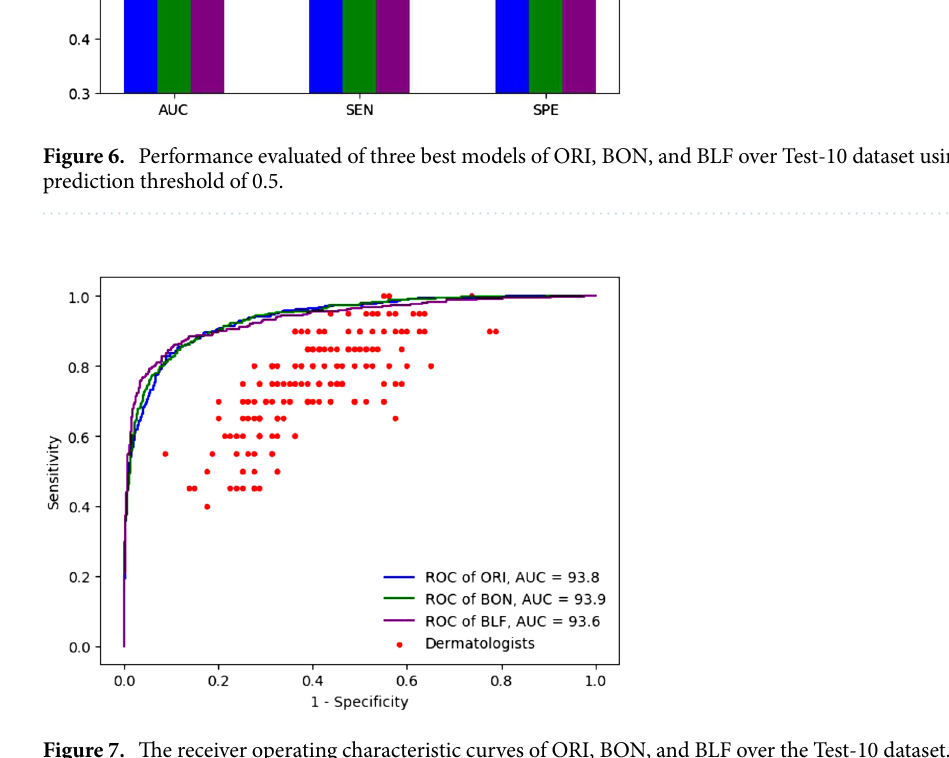
Figure 7. The receiver operating characteristic curves of ORI, BON, and BLF over the Test-10